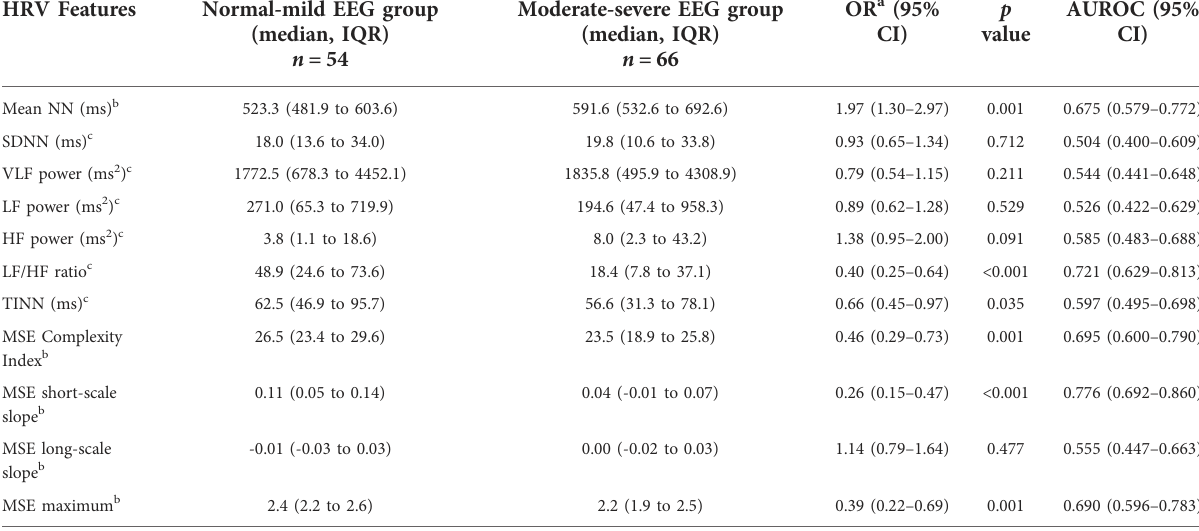
TABLE 2 HRV univariable analysis. HRV